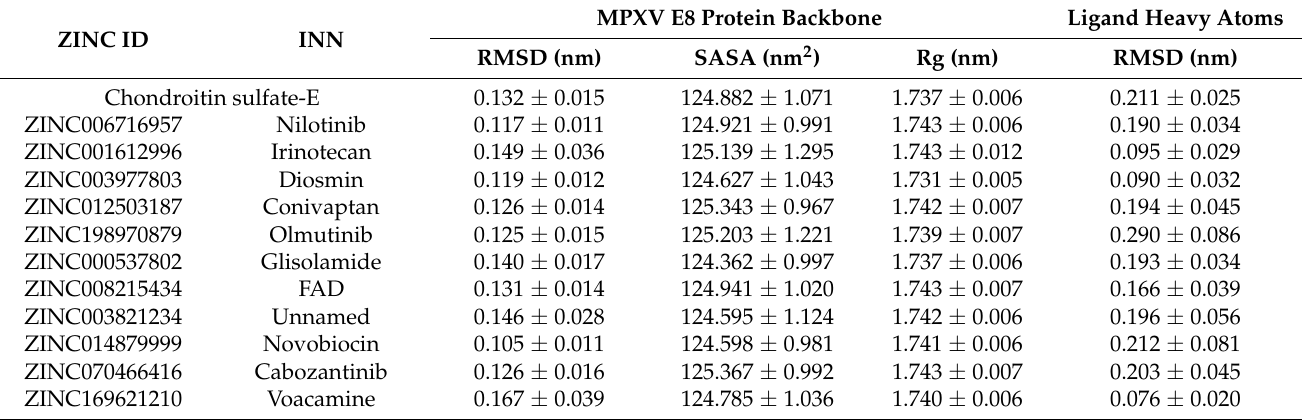
Table 1. The mean and standard deviation of protein backbone RMSD, solvent accessible surface area (SASA), radius of gyration (Rg), and ligand RMSD values calculated from the data of 100 ns MDs trajectories of the MPXV E8 protein in complex with CS-E and the 11 hit compounds. MPXV E8 Protein INN